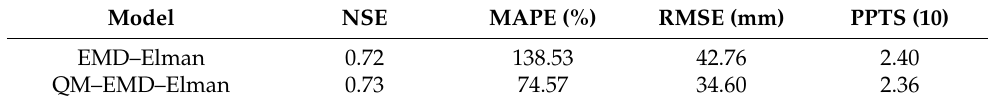
Figure 12. Trend changes in the NSE indicator for the three models.